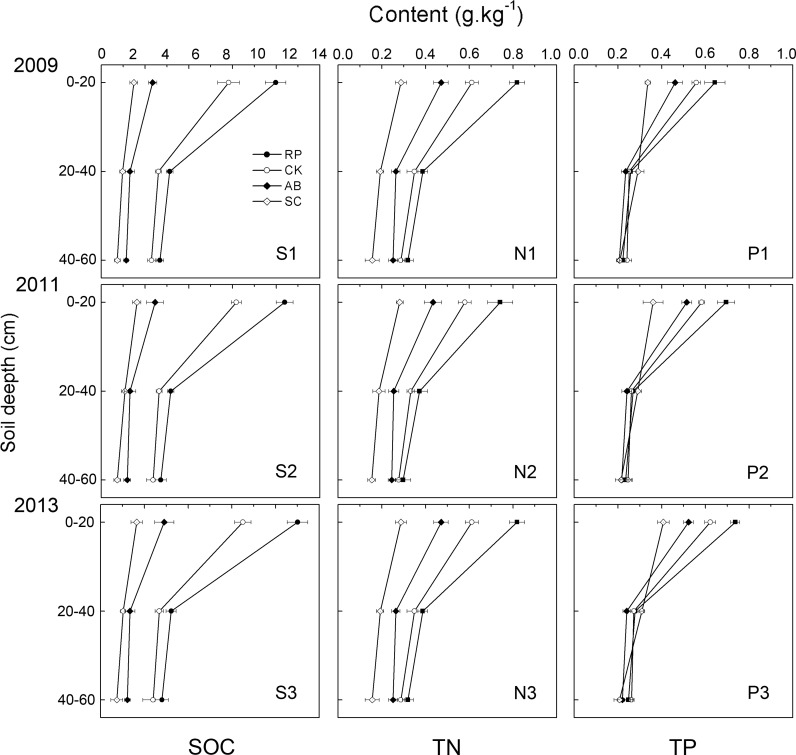
Soil contents of SOC, TN, and TP for different land use types and soil depth in 2009, 2011, and 2013.Bars represent standard errors.